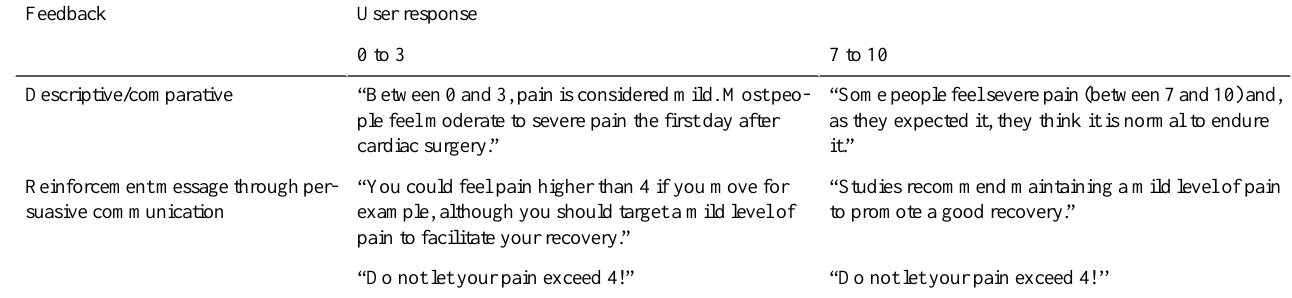
pain to facilitate